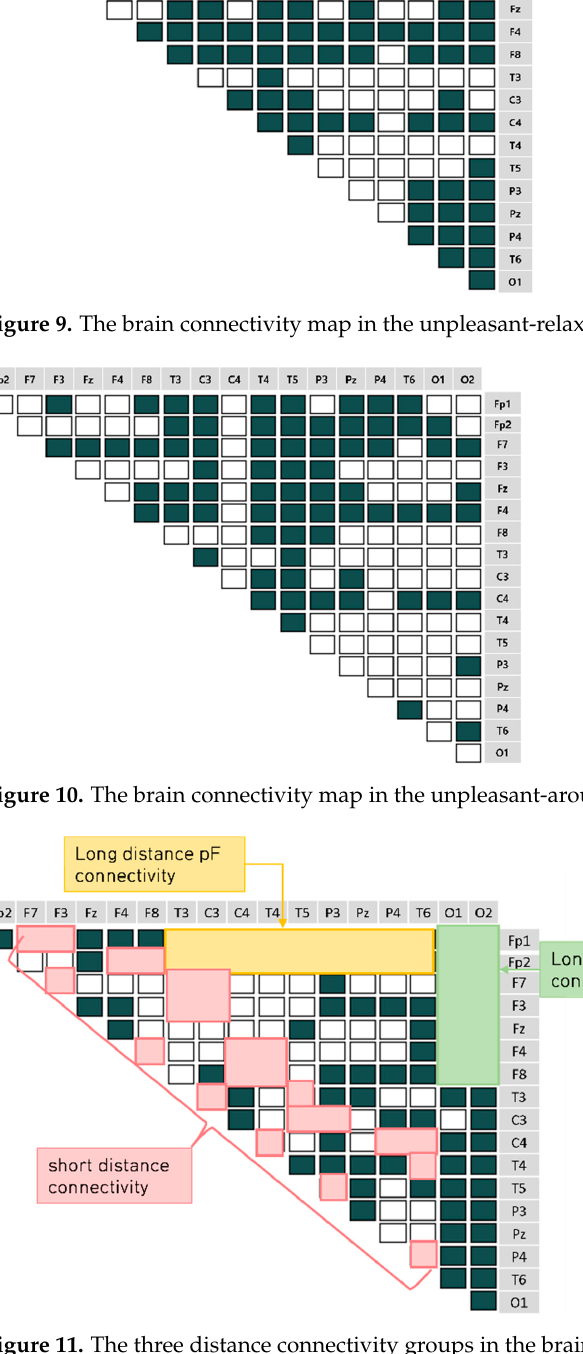
Figure 11. The three distance connectivity groups in the brain connectivity map.